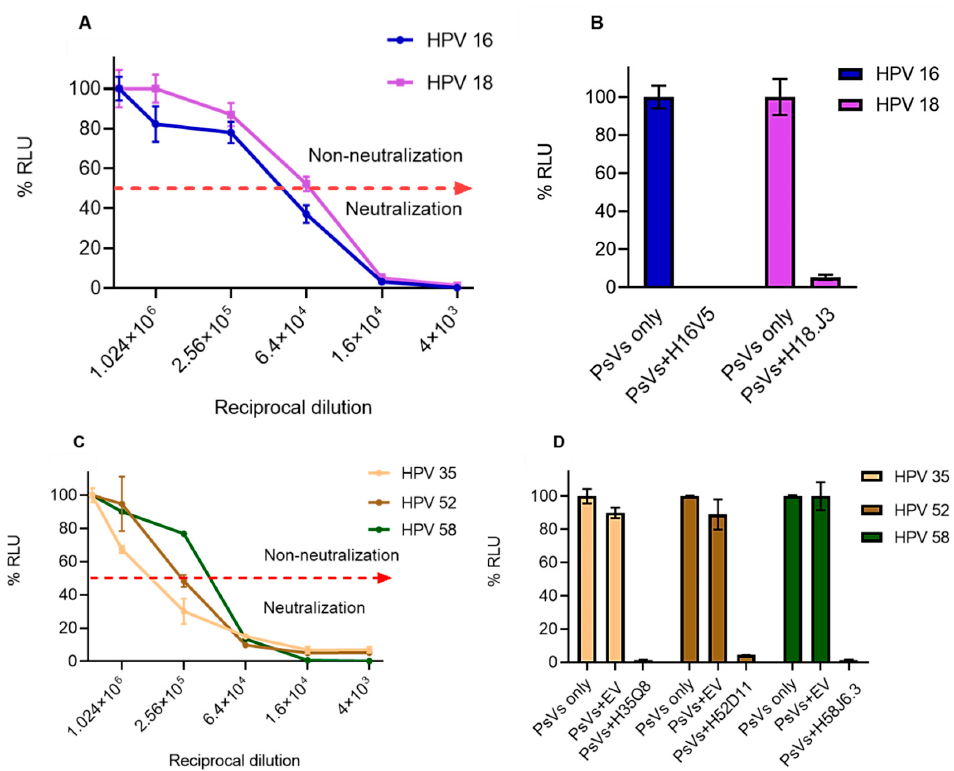
Figure 4. In vitro PsV neutralization titres in L1 PBNA. Purified PsVs of HPV types 16, 18, 35, 52, and 58 were used in L1-PBNAs to detect L1-specific neutralizing antibodies in sera obtained from vaccinated mice. ( A ) Neutralization of HPV 16 and 18 PsVs with pooled Gardasil ® mouse sera, the cut off for anti-L1 neutralizing titres was a 50% reduction of SEAP signal (dashed red line). ( B ) Positive control monoclonal antibodies H16V5 and H18.J3 were able to neutralize HPV 16 and 18 PsVs completely. ( C ) Pooled sera from mice vaccinated with plant-produced VLPs tested for neutralization of homogenous PsV types (HPV 35, 52 and 58). The red dashed line indicates the cut off for anti-L1 neutralizing titres (50% reduction of SEAP signal). ( D ) Positive and negative control neutralization of PsVs: empty vector (EV) negative, positive control monoclonal antibodies (H35Q8 for HPV 35, H52D11 for HPV 52, and H58J6.3 for HPV 58). Markers and error bars indicate mean values and standard deviation from triplicate readings. Table 2. Summary of in vitro PsV neutralization titers in L1 PBNA.